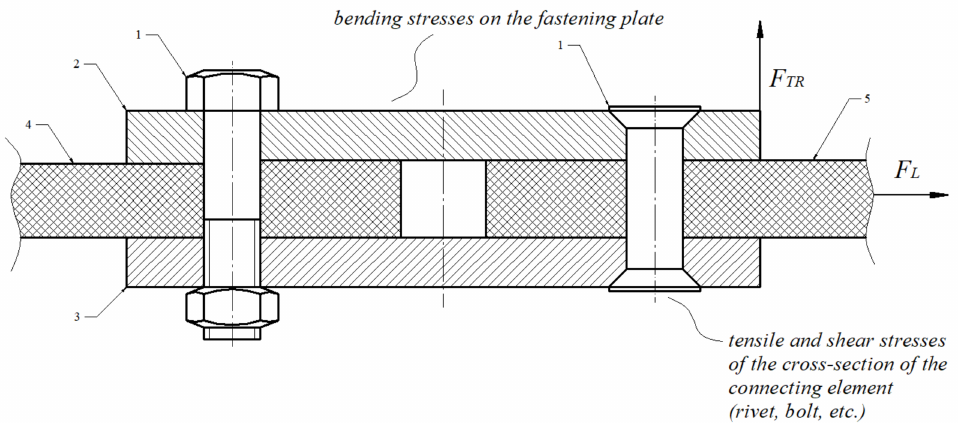
Figure 4. Cross-section of the fastener showing the forces loading the components of the mechanical fastener itself. Explanations: 1—connector/link, 2—upper joint plate, 3—lower joint plate, 4—one end of the conveyor belt, 5—the other end of the